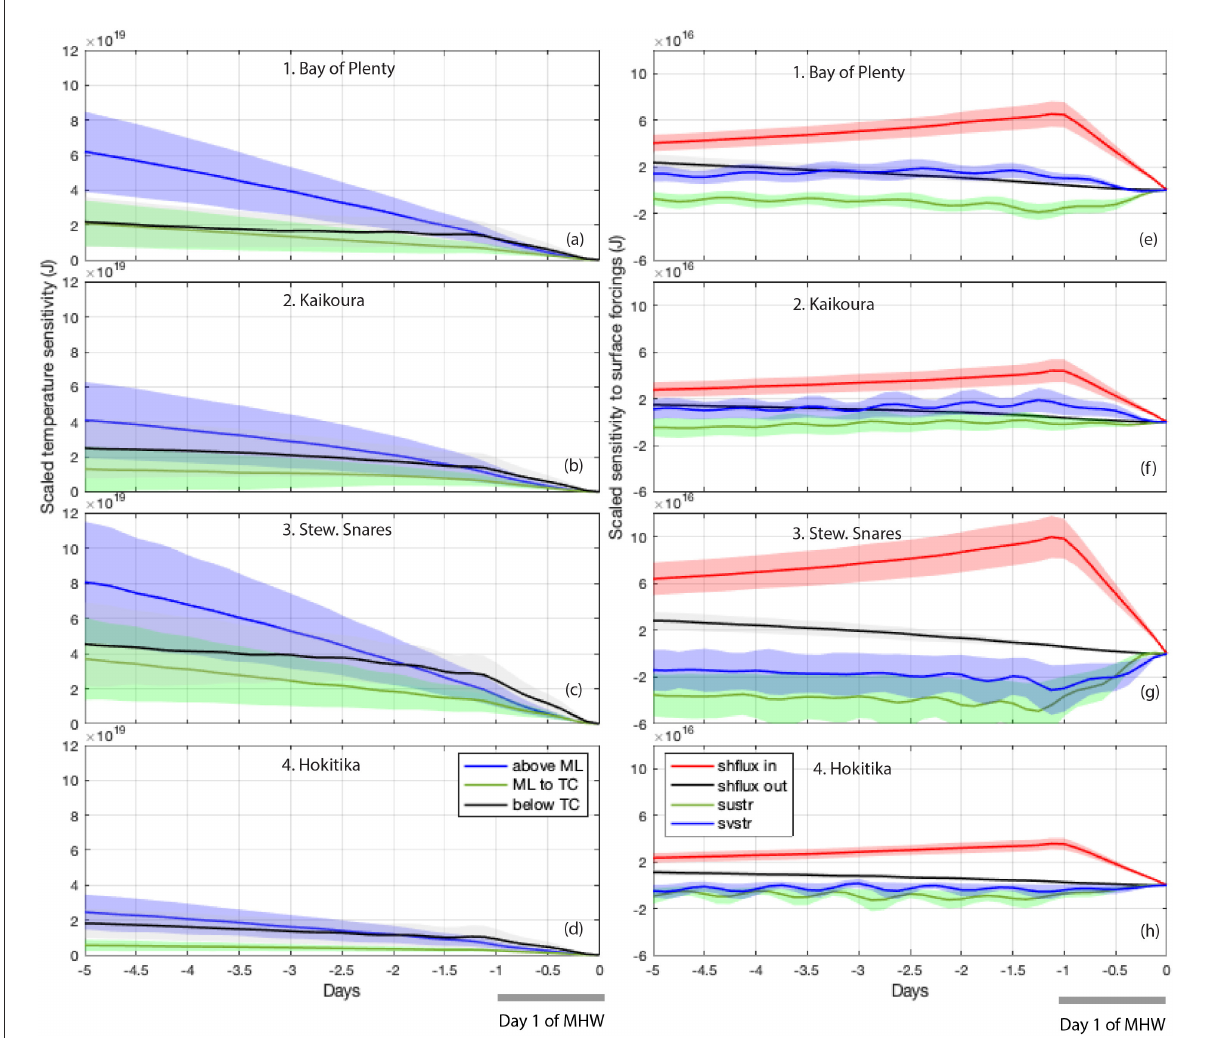
FIGURE4 Domain-integrated scaled sensitivities to temperature ( left column ; a–d ) and surface forcings ( right column ; e–h ) over the 5-day adjoint simulations. Temperature sensitivities are for temperature outside of the region and separated by depth and surface heat flux sensitivities are separated into inside and outside of the region. The sensitivities are scaled by the 5-day standard deviations. The magnitudes indicate the amount by which J changes if variable is changed by 1 standard deviation everywhere in the domain for 4 days leading up to the MHW. The magnitudes of J can be compared to those in Figure